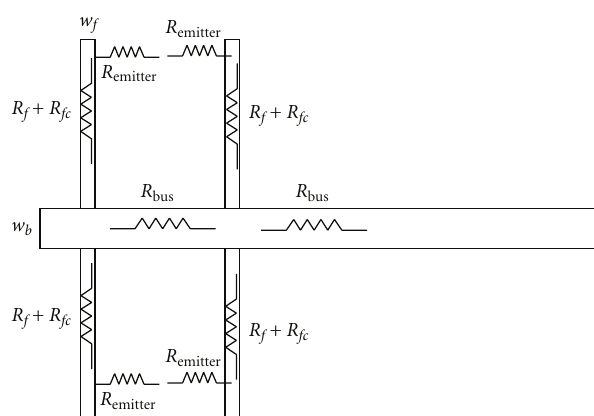
Figure 10: Indicating the resistive network in the top region of the solar